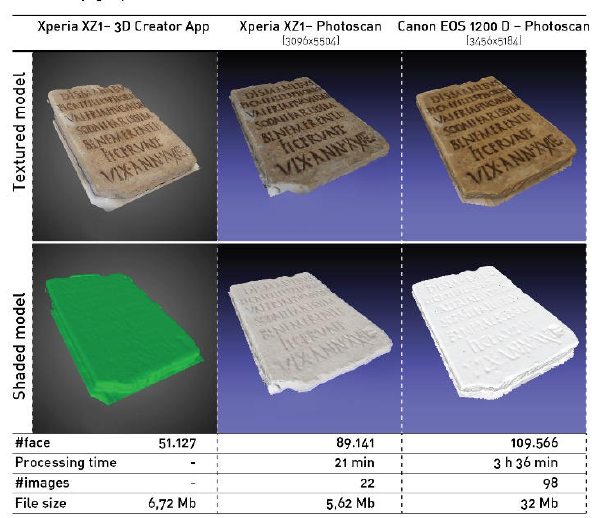
Figure 8. Comparative assessment-matrix on Roman